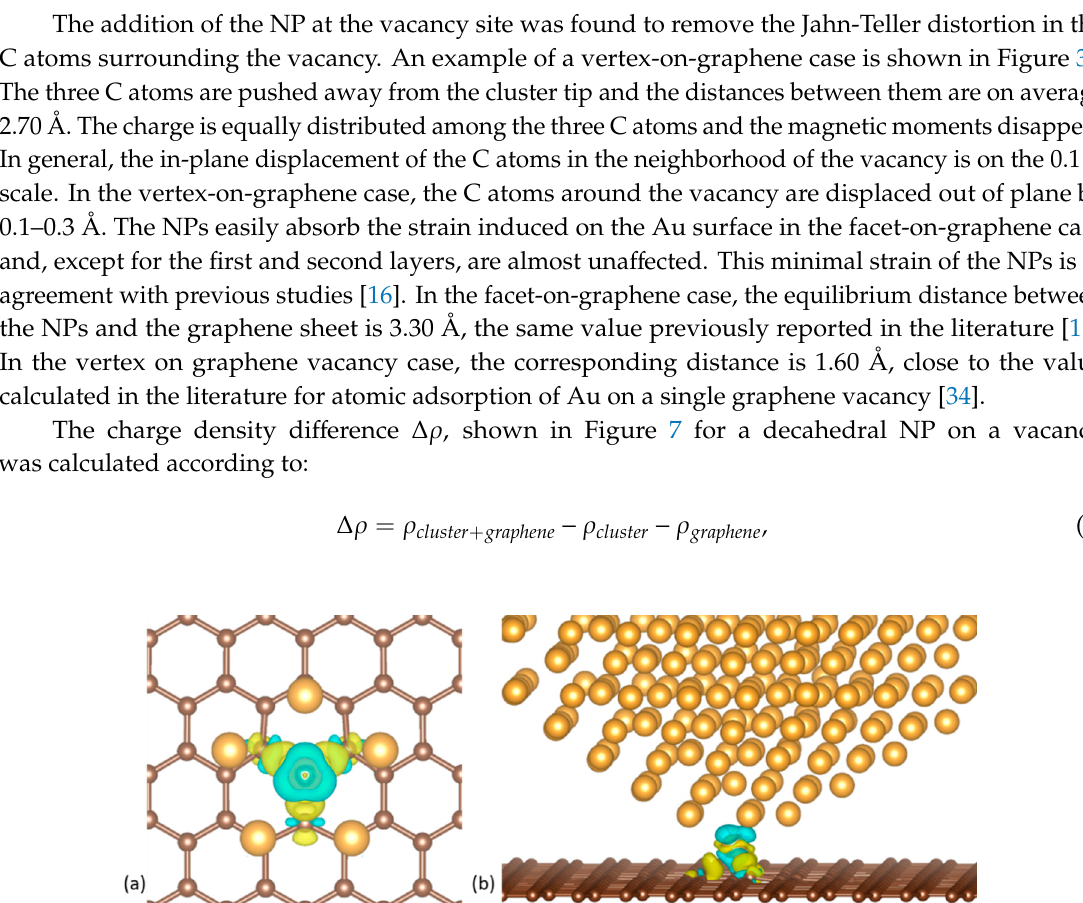
Table 2. The binding energies (eV) of the Au 561 NPs are oriented with a vertex on pristine graphene and on a graphene vacancy.